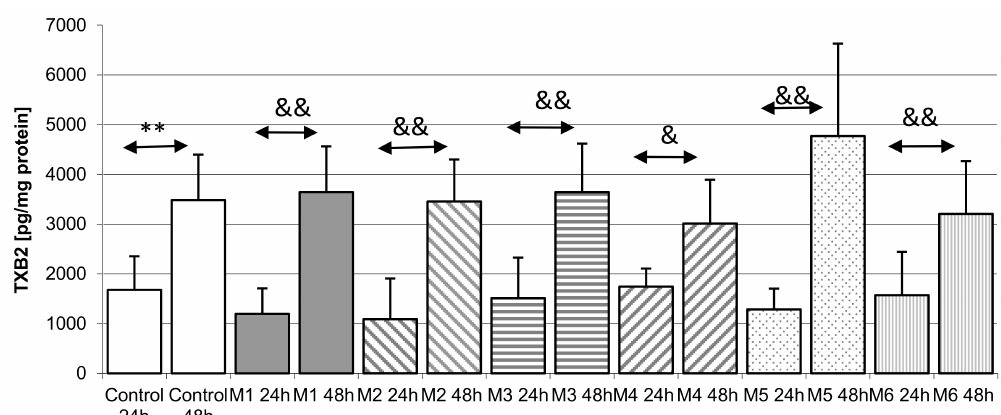
Figure 5. The quantity of thromboxane TXB 2 in macrophages cultured with various plates and dedicated screws used for surgical treatment of condylar fractures. Macrophages were cultured for 24 h and 48 h in RPMI medium with 10% FBS with various plates and dedicated screws: ( A ) SYNTES (S1, S2, S3); ( B ) MARTIN (C1, C2, C3, C4); ( C ) MEDARTIS (M1, M2, M3, M4, M5, M6); for details see Table 1). After incubation cells were harvested by scraping and TXB 2 concentration was measured by ELISA. Experiments were conducted as six separate assays, each assay in three replicates, ( n = 18). * Statistically significant differences in comparison to control 24 h ( p ≤ 0.05), ** Statistically significant differences in comparison to control 24 h ( p ≤ 0.001), # Statistically significant differences in comparison to control 48 h ( p ≤ 0.05), & Statistically significant differences in comparison to appropriate plate 24 h ( p ≤ 0.05), && Statistically significant differences in comparison to appropriate plate 24 h ( p ≤ 0.001). Control cells were incubated in RPMI medium with 10% FBS.